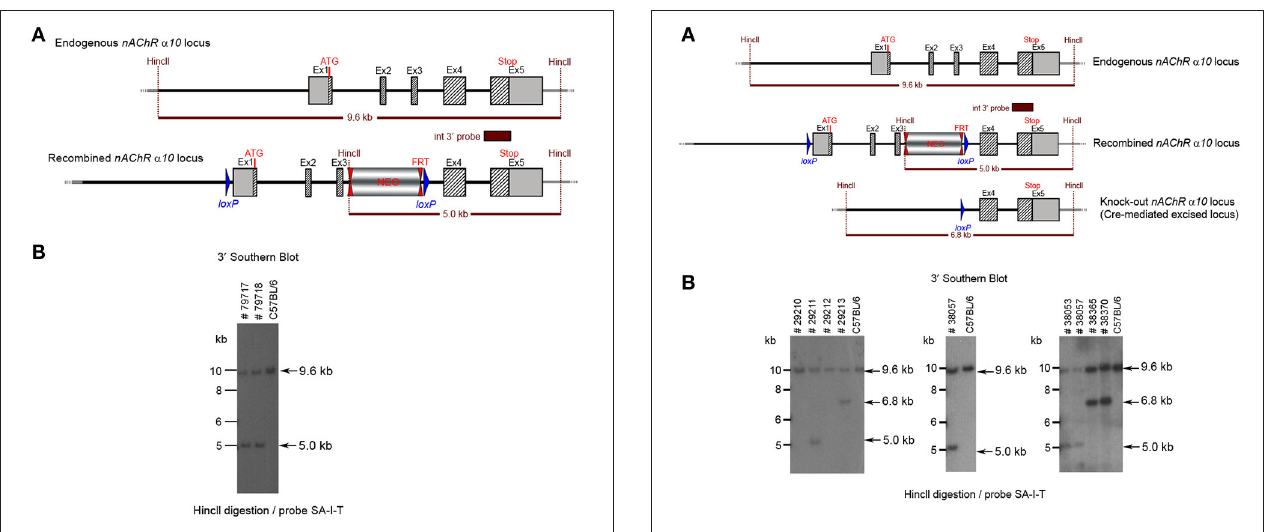
FIGURE 7 | (A) The schemata for the endogenous and recombined α 9 nAChR loci. (B) The Southern blot analysis of the α 10 F1 generation. The genomic DNA of the two 80% chimeric F1 mice (#79717, #79718) from clone 1-1D was compared with C57BL/6J wildtype DNA. The HincII digested DNAs were blotted on nylon membrane and hybridized with the internal 3 ′ probe (SA-I-T) to validate the heterozygosity of the nAChR α 9 gene mutation.